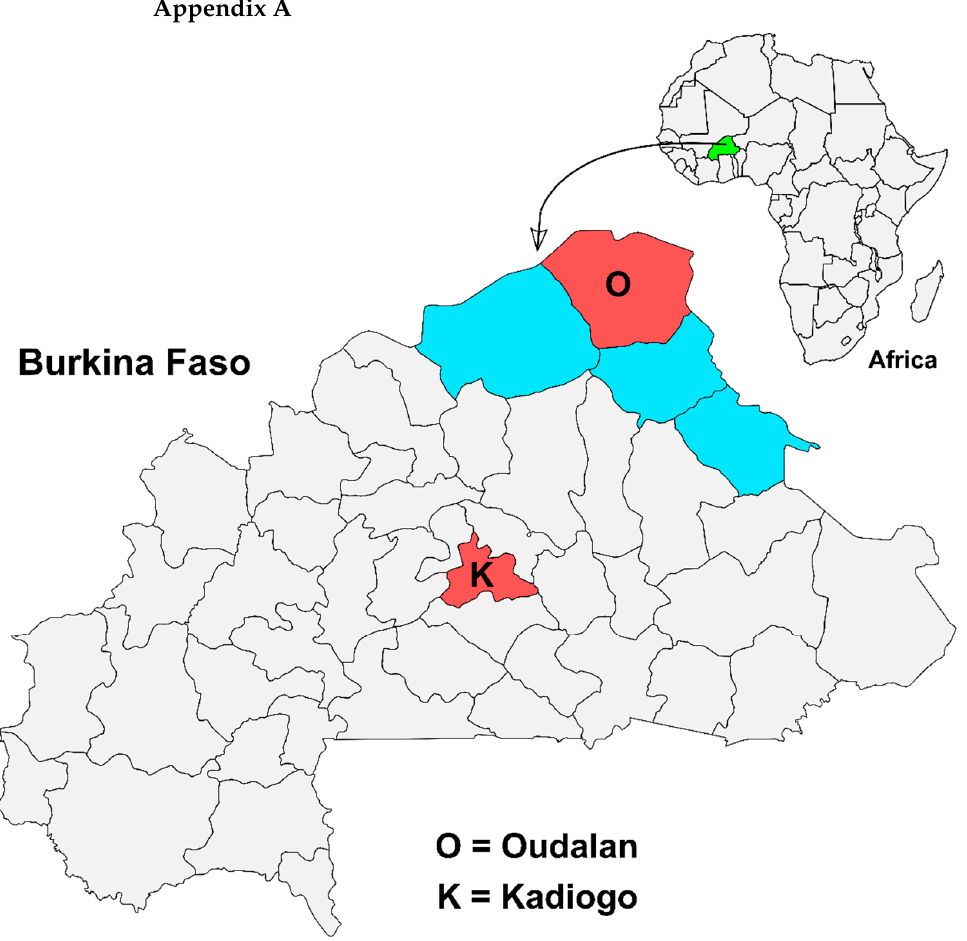
Figure A1. Map of Burkina Faso showing the study area of the study “Prevalence and molecular characterization of Mycobacterium bovis in slaughtered cattle carcasses in Burkina Faso”. The sampling sites “O” (Oudalan) and “K” (Kadiogo) provinces are highlighted in reddish color and the other three provinces of the Sahel region are highlighted in light sky-blue color.